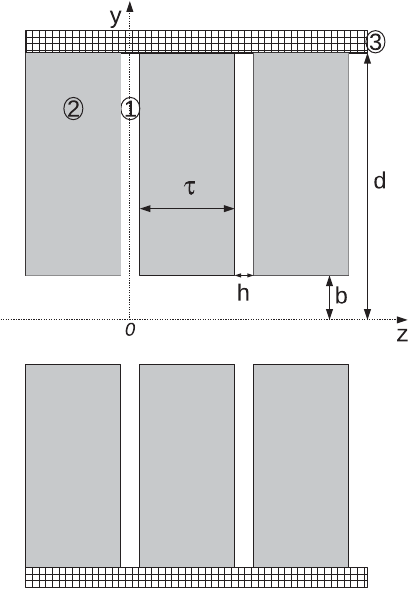
FIG. 3. Parallel-plane beam chamber with laminations. Subscript ‘‘1’’ denotes the crack and subscript ‘‘2’’ the lamina- tion. The laminations are shorted by an ideal conductor ‘‘3.’’ The beam flows in the z direction; the x direction is perpendicular to the plane of the